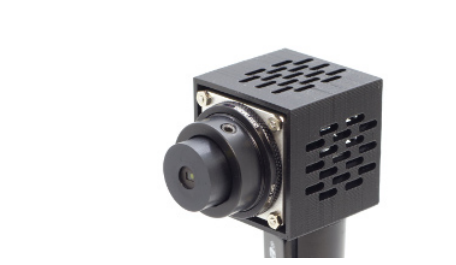
Figure 2: Optic design of the prototype.